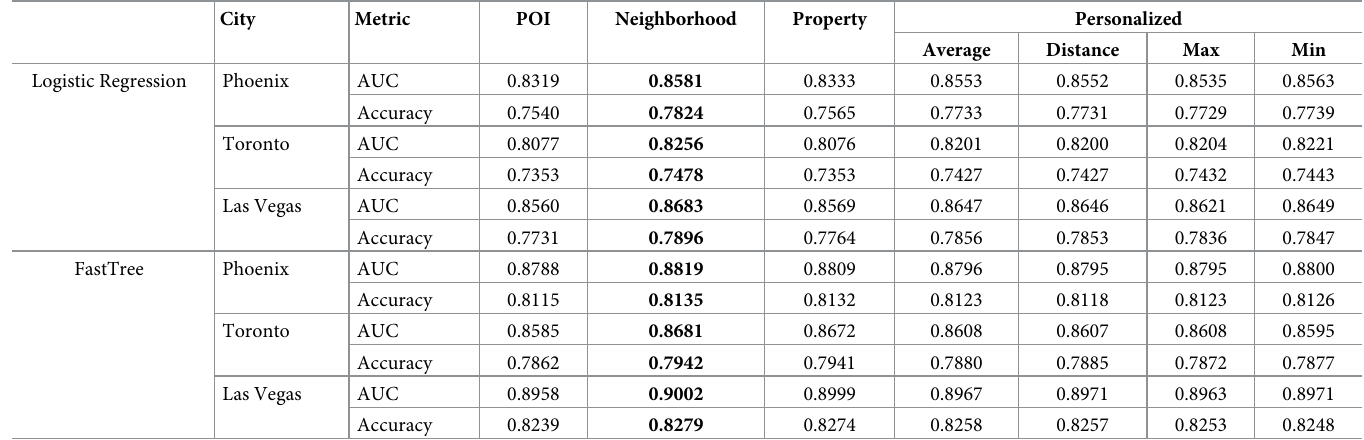
Table 3. AUC and accuracy for different classifiers on different combination of